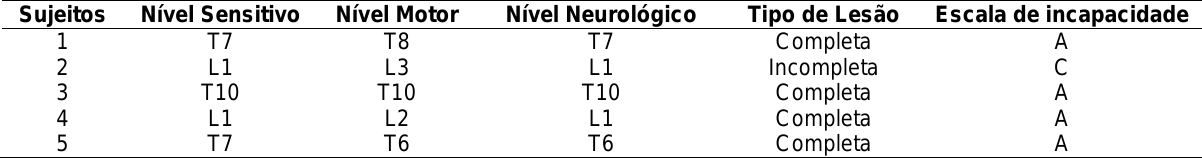
Tabela 1. Dados clínicos de caracterização da amostra segundo a ASIA